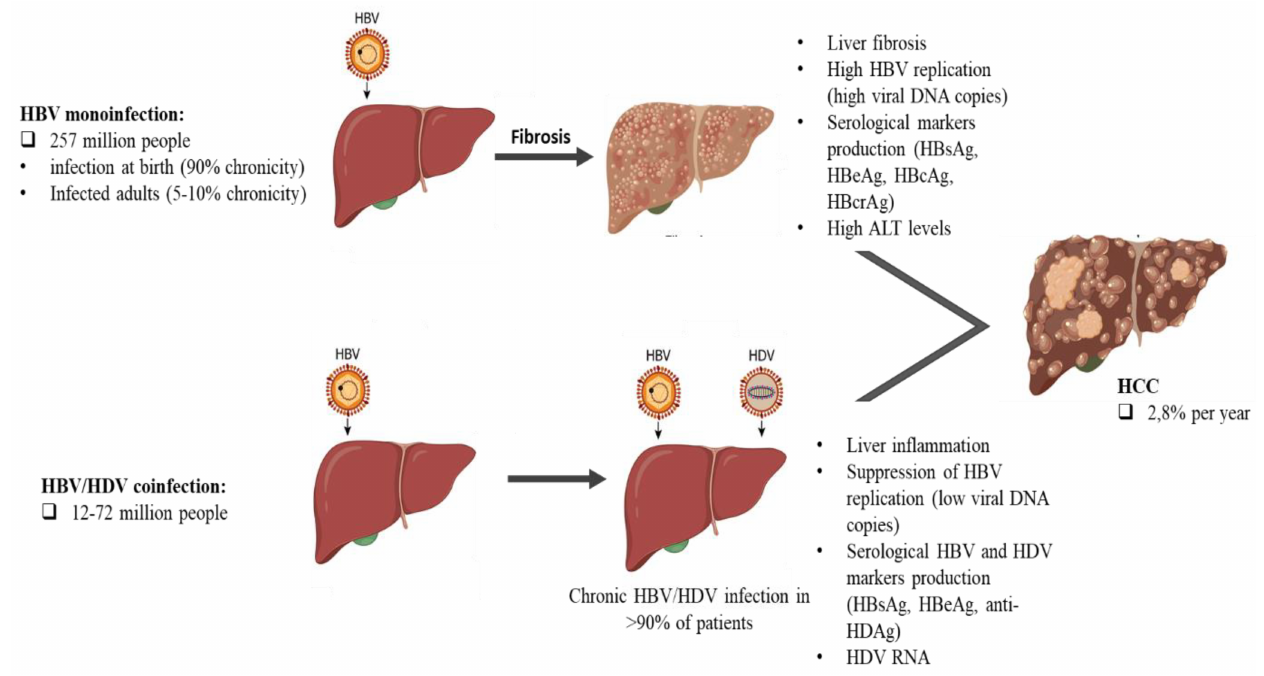
Figure 1. Representation of HBV monoinfection and HBV/HDV coinfection disease